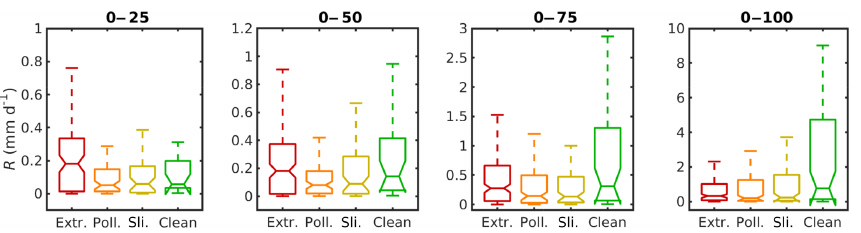
Figure A2. Daily cumulative runoff ( R ) stratified by different pollution level (extremely polluted air, polluted air, slightly polluted air, and fairly clean air) and daily precipitation percentiles from low precipitation (0–25) to all precipitation events (0–100) for 2001–2013. The notches indicate 95% confidence levels. Outliers are not shown. See “Statistical methods” for details. See also Fig.